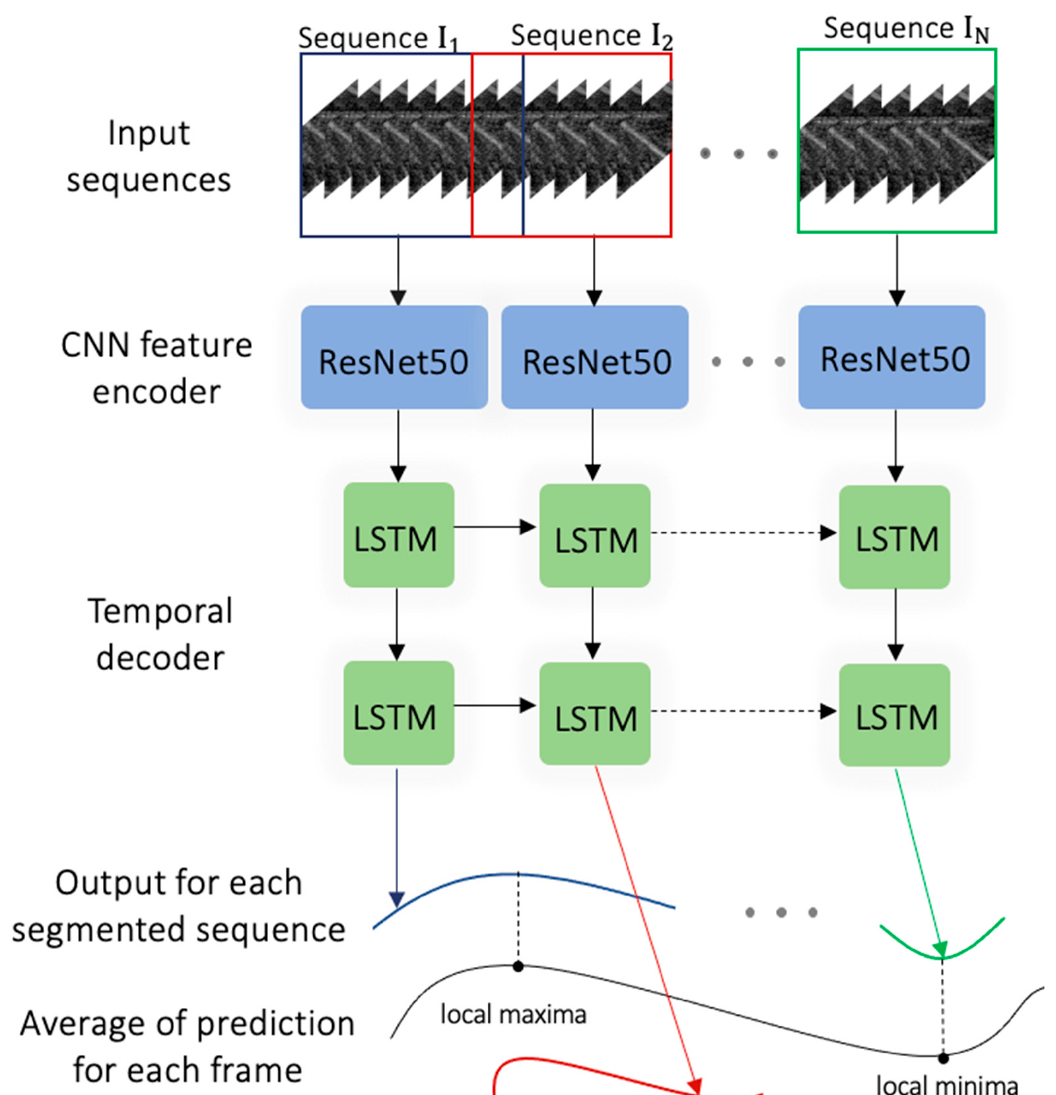
Figure 4. Schematic of the proposed convolutional neural network with two long short-term memory (LSTM) units. The individual segmented sequences that are input to the ResNet model [35] are then processed by two layers of LSTM units. Finally, the sliding window method processed fixed, overlapped, chunked sequences, generating multiple predictions for each frame. Once the local minima and the local maxima are identified for overlapping sequences, the average prediction fascicle length is then reconstructed from each subsegment.